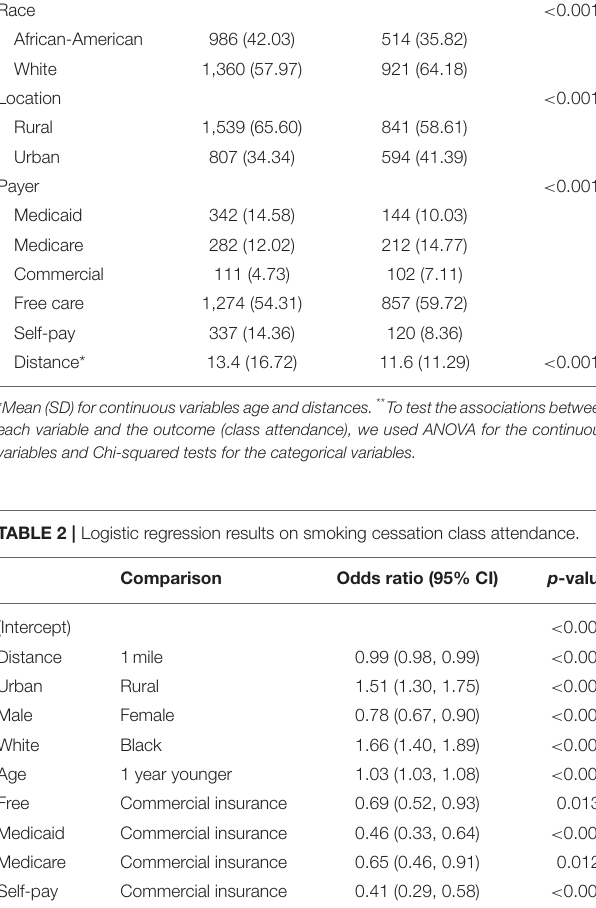
gender ( Figure 3A ), race ( Figure 3B ), and payment method ( Figure 3C ). The relationship was not changed significantly by the three variables as indicated by the almost parallel lines depicting the distance-class attendance relationship. Generally, at the same distance, males, African Americans, and patients with Medicaid or self-pay had lower class attendance rates compared with their